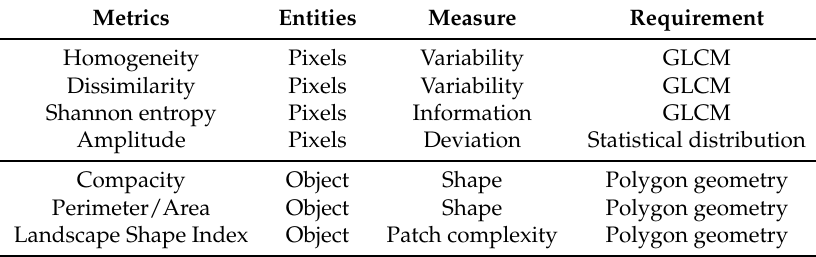
Table 1. Metrics used for the experiments ; GLCM: Grey Level Cooccurrence Matrices. Metrics Entities